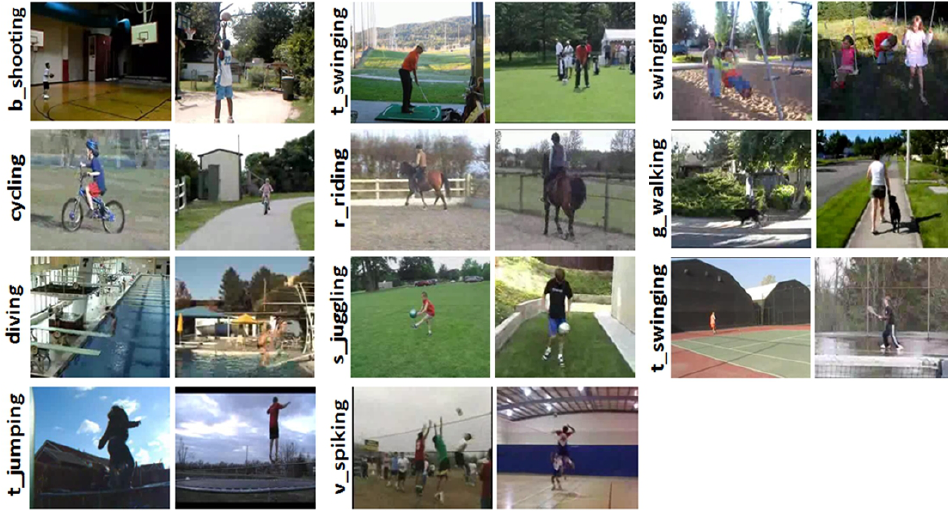
Figure 7. Sample images from the UCF YouTube Action Dataset